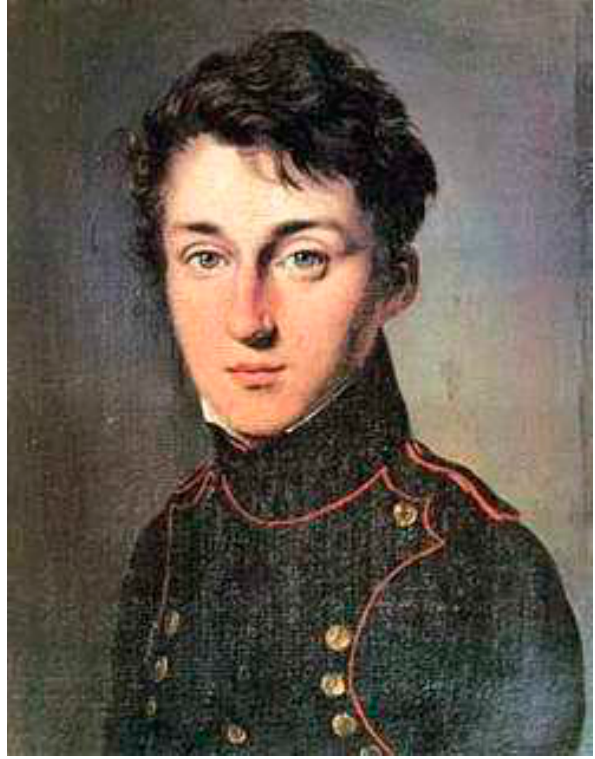
Figure 2. Sadi Carnot at the age of